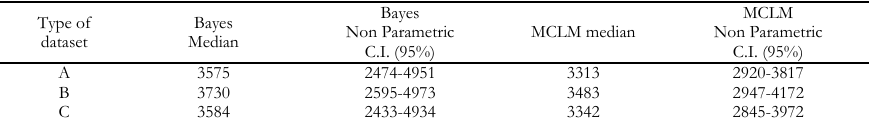
Population size estimated by the Bayesian model, with a priori upper bound equal to the upper limit of the nonparametric 95% C.I. obtained by the MCLM without covariate, compared with the population size estimated by the MCLM without covariate Bayes Type of Bayes Non dataset Median